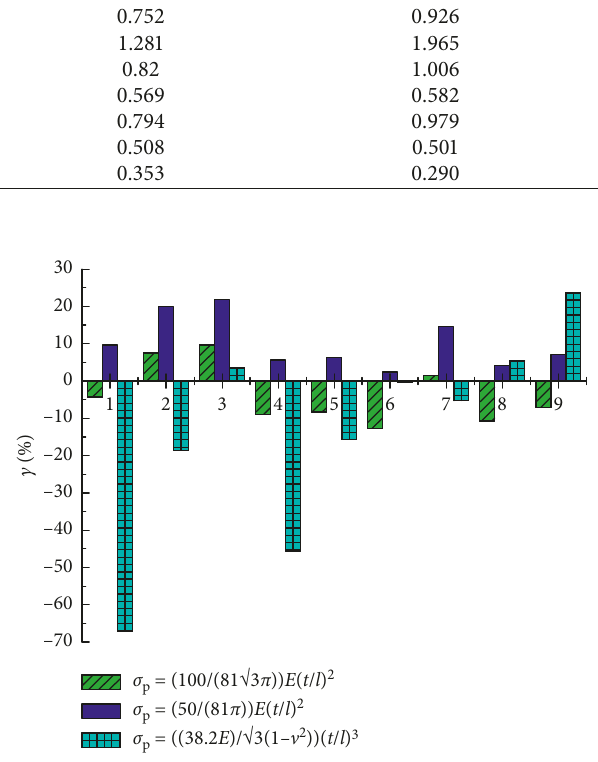
Figure 11: Histogram of the three peak stress formulas with